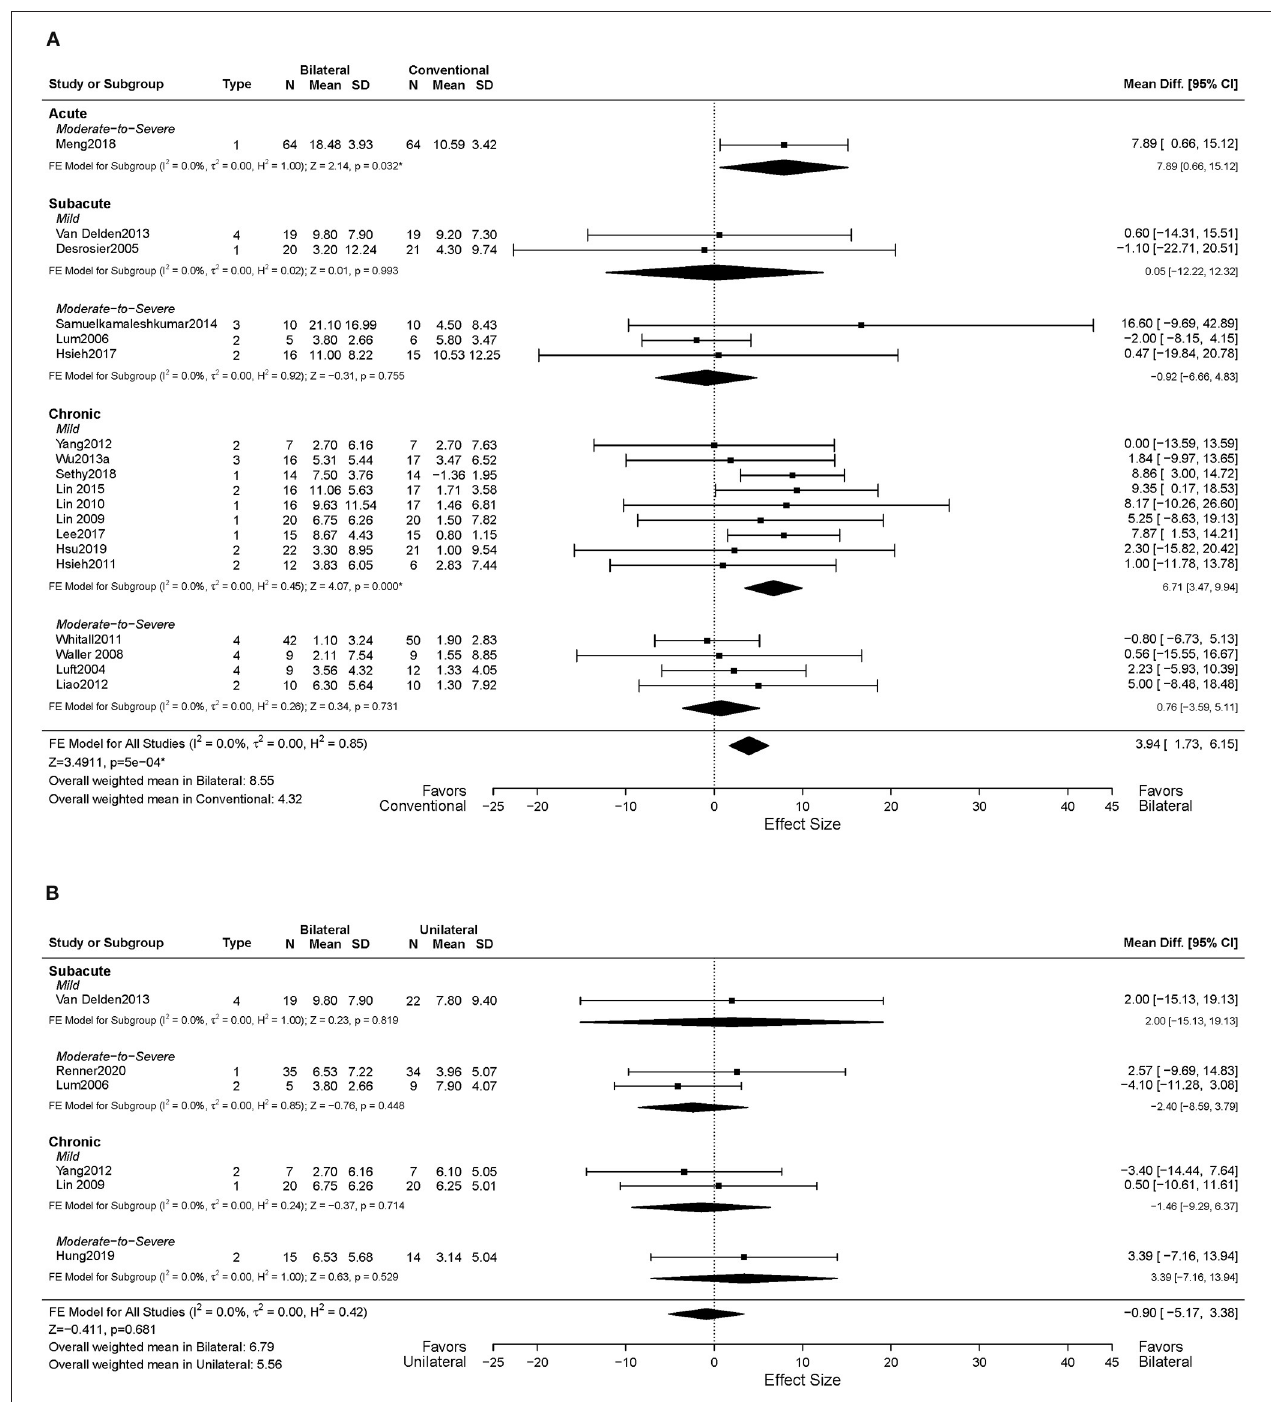
FIGURE 3 | Forest plots comparing the effects of (A) BAT vs. CT and (B) BAT vs. UAT on the upper extremity motor impairment. 1 = bilateral functional training Test (BFTT); 2 = bilateral robot-assisted training (BRAT); 3 = bilateral arm training with rhythmic auditory cueing (BATRAC); 4 = mirror therapy (MT); BAT, bilateral arm training; CI, confidence interval; CT, conventional therapy; FE, fixed-effects; RE, random-effects; Std. Mean Diff., standardized mean difference; UAT, unilateral arm training; * indicates statistically significant ( p <